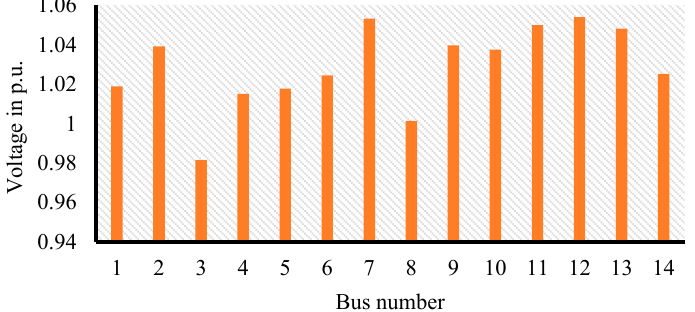
Figure 3. Bus voltage profile for IEEE 14-bus system.